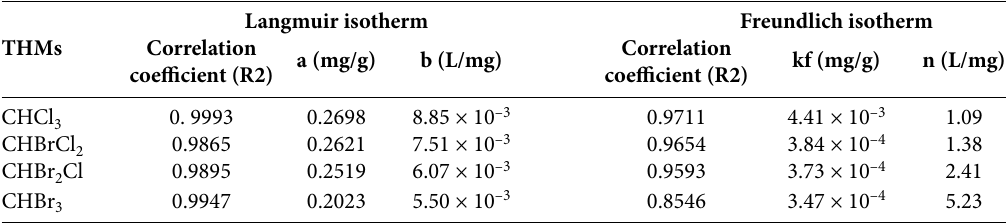
Table 5. Constants and correlation coefficients of the Langmuir and Freundlich isotherms Langmuir isotherm Freundlich isotherm THMs Correlation Correlation a coefficient (R2)